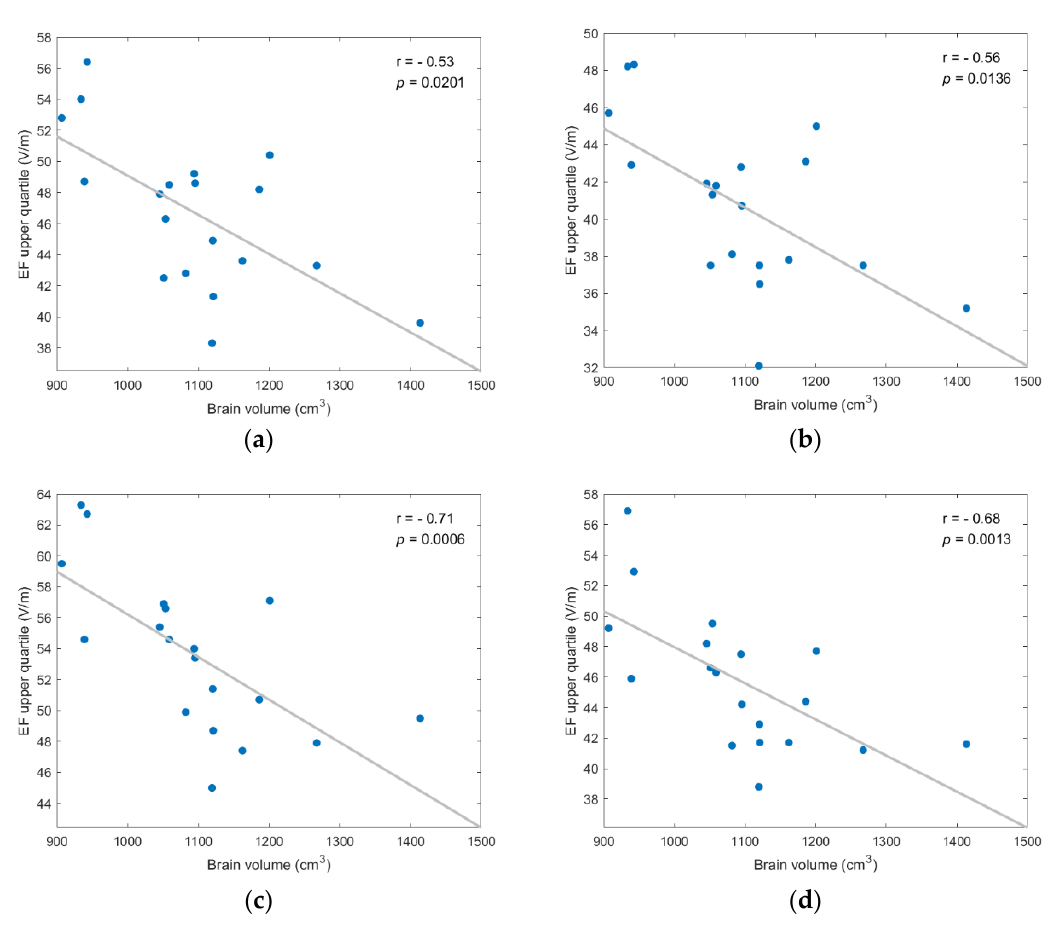
Figure A6. EF upper quartile showed strong, and statistically significant negative, correlation to brain volume for every coil position/model version scenario; ( a ) frontal coil position on anatomical models; ( b ) frontal coil position on homogeneous models; ( c ) central coil position on anatomical models; ( d ) central coil position on homogeneous models.